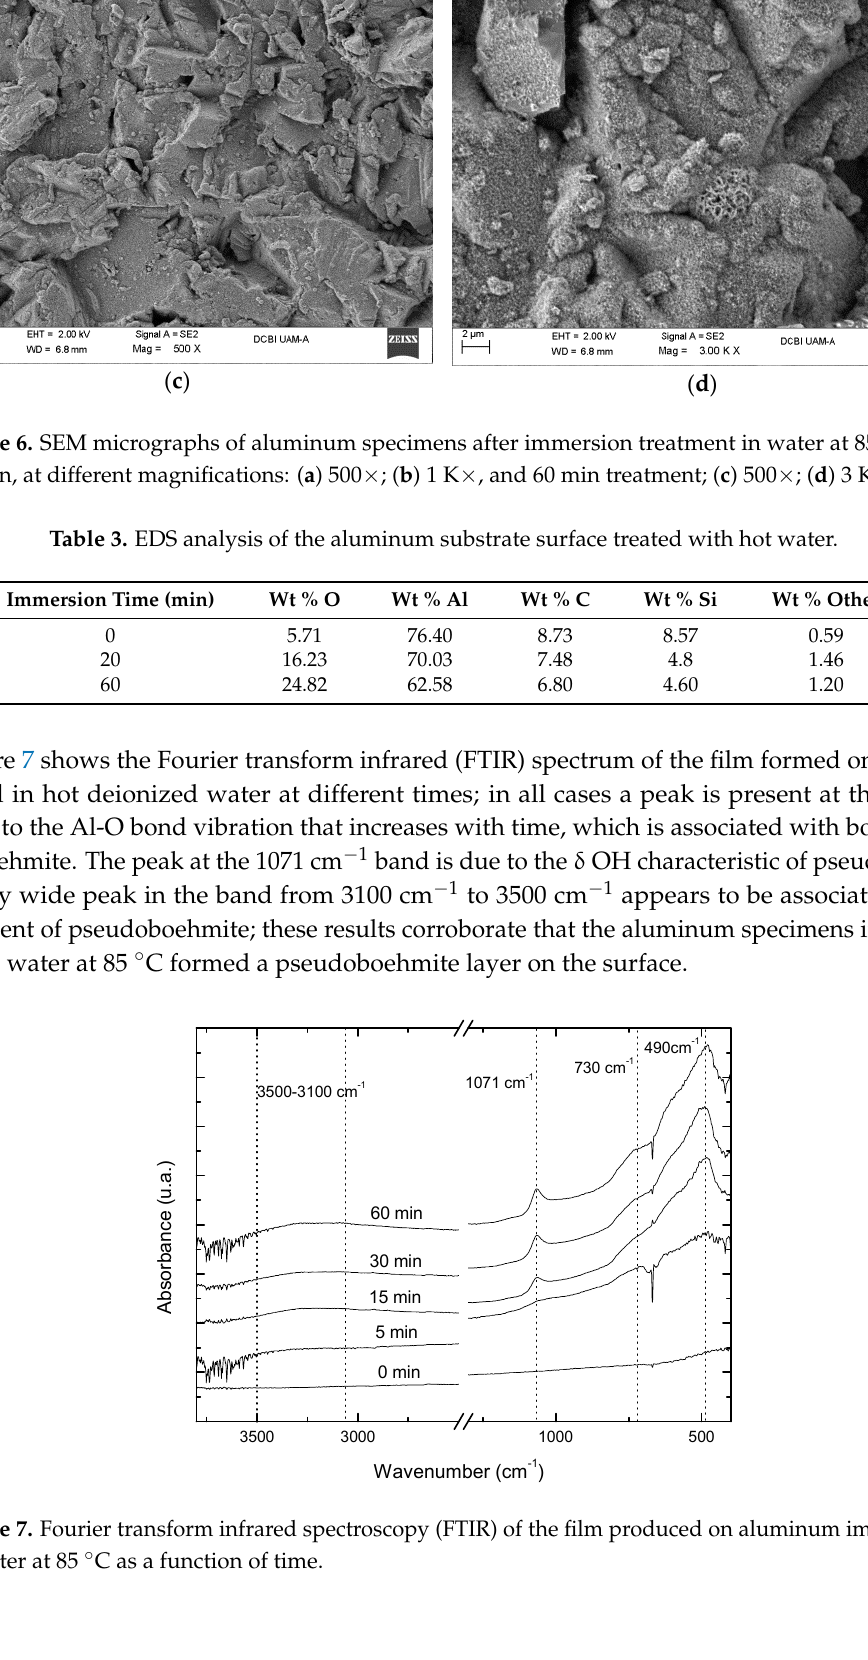
Figure 6. SEM micrographs of aluminum specimens after immersion treatment in water at 85 °C for 20 min, at different magnifications: ( a ) 500×; ( b ) 1 K×, and 60 min treatment; ( c ) 500×; ( d ) 3 K×.